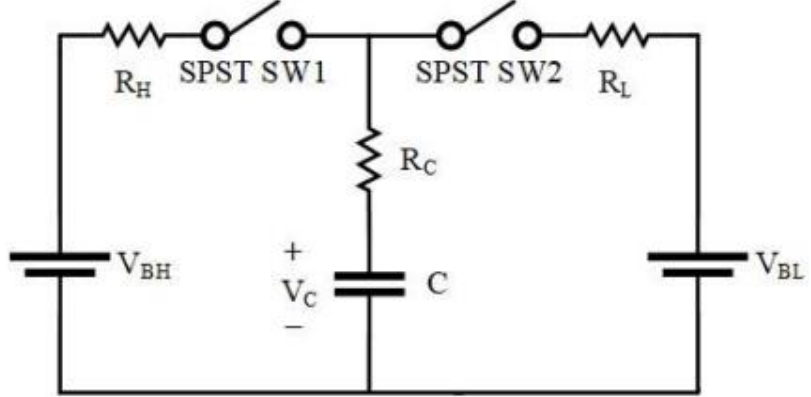
Figure 8. Balanced circuit diagram between two